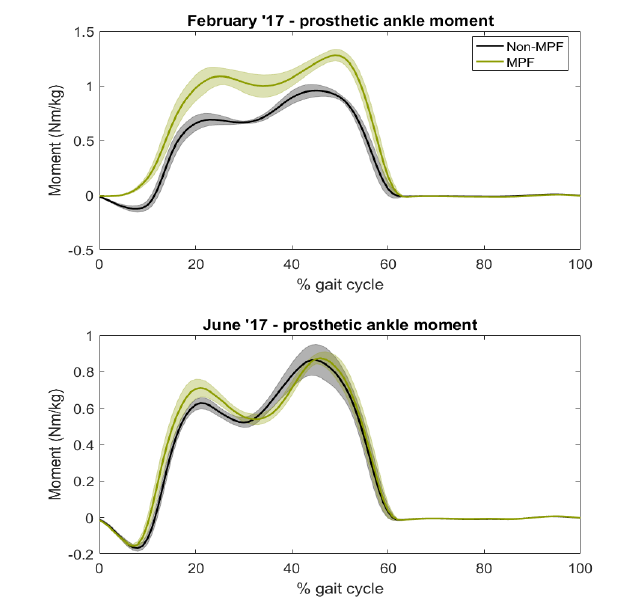
Figure 1: The prosthetic ‘ankle’ moment plots for a trans-tibial amputee with MPF-off (black) and MPF-on (green), for test sessions four months apart